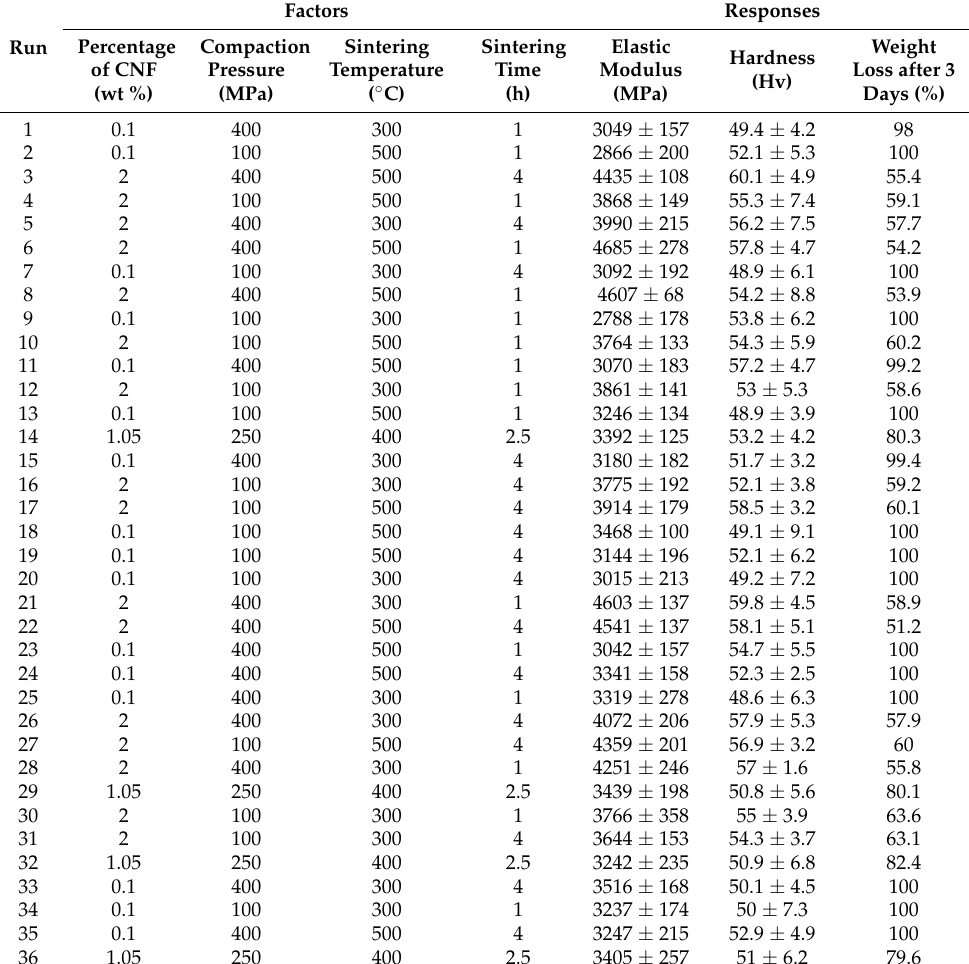
Table 2. Full factorial design matrix together with the average screening factor output